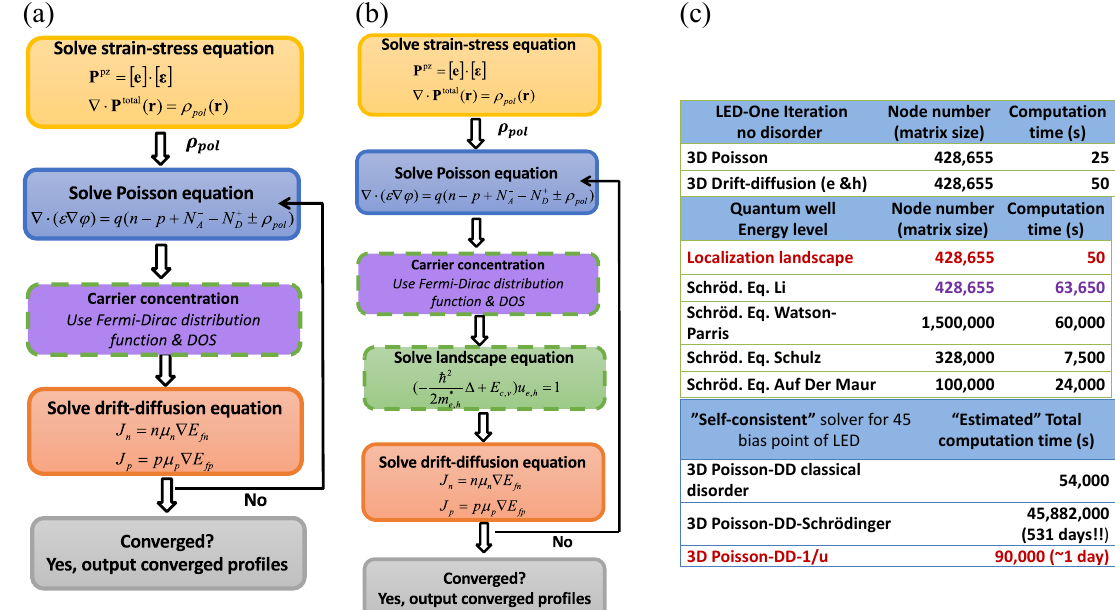
Figure 5: LED simulation algorithm.